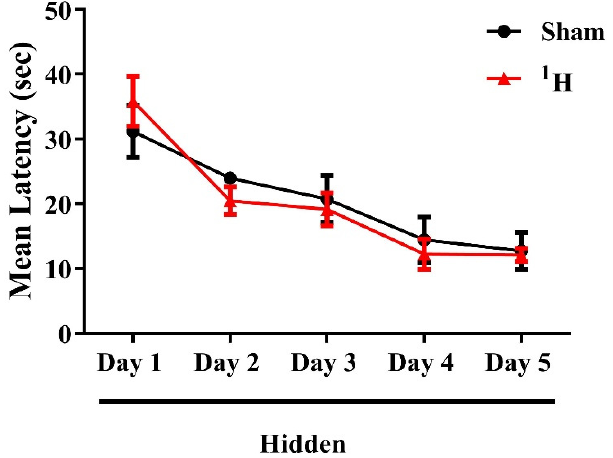
Figure 4. Morris water maze latency. There were no significant differences in treatment-by-day in- teractions for latency. Hidden indicates the platform was not visible during the training trials.